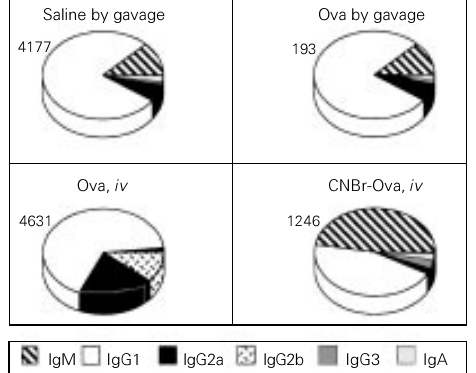
Figure 6 - Previous cleavage of the antigen influences tolerance induction. Eight-week-old B6D2 F1 mice were treated with 20 mg ovalbumin (Ova) by gavage or by intravenous injection of 500 (cid:181)g native Ova or 500 (cid:181)g of cyanogen bromide-treated Ova (CNBr-Ova) 7 days before ip im- munization. All mice were im- munized as described in the leg- end to Figure 1. The numbers above the pies indicate the glo- bal ELISA score of each group. Both oral treatment with Ova and iv injection of CNBr-Ova in- duced oral tolerance (P<0.001) but cleavage of the antigen led to a preferential suppression of